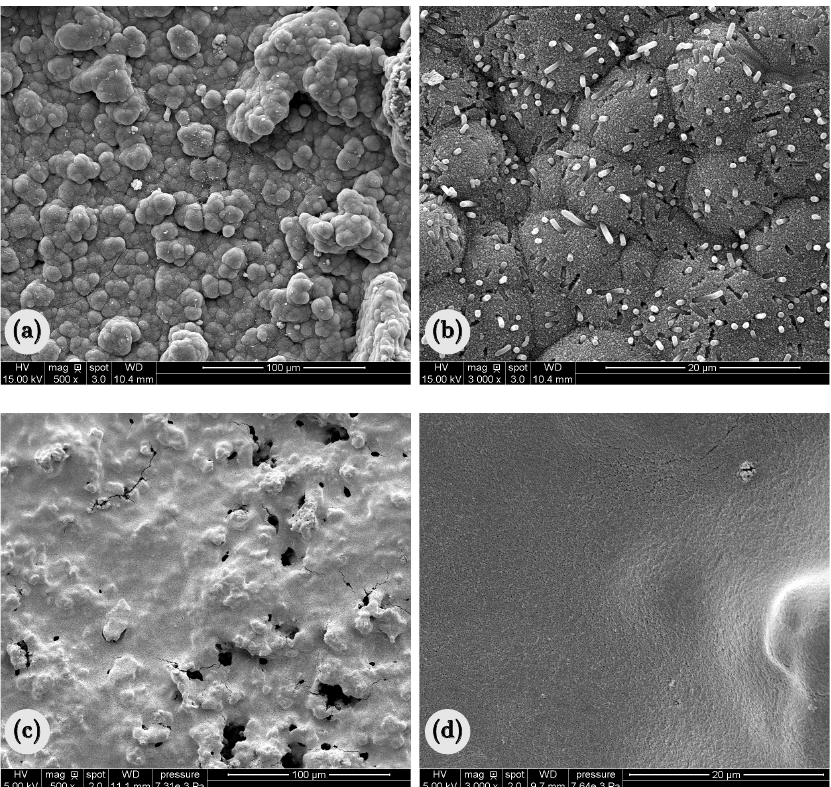
Figure 6. SEM images (secondary electron mode) of samples after 24 h of experiment. ( a , b ) SEM images of control samples without TiO 2 ( × 500 and × 3000) showing an organic matrix and ovoid bacteria encased by or near surface of this dense network of curli fibers. ( c , d ) SEM images of TiO 2 -coated samples that have not been inoculated ( × 500 and × 3000) showing the surface of coating